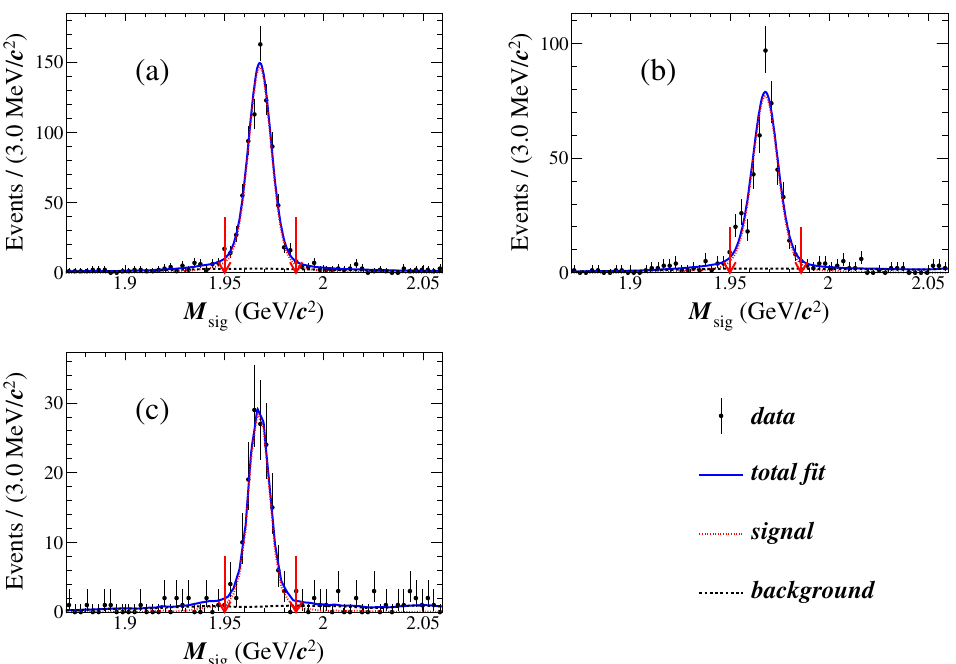
Figure 1 . Fits to the M sig distributions of the accepted signal candidates from the data samples at √ s = (a) 4.178 GeV, (b) 4.189–4.219 GeV and (c) 4.226 GeV. The black points with error bars are data. The blue solid lines are the total fits. The red dotted and black dashed lines are the fitted signals and backgrounds, respectively. The pairs of red arrows indicate the signal